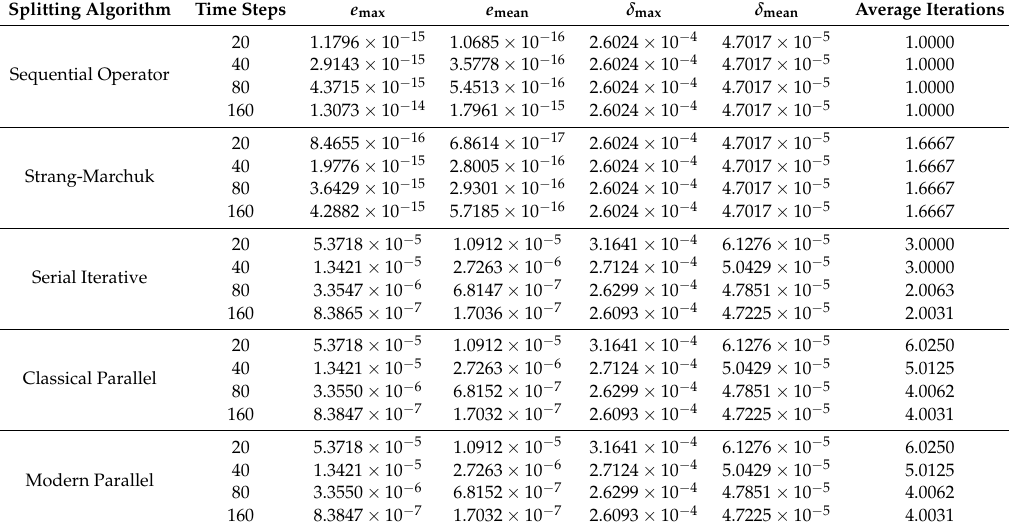
Table 8. Diffusion problem. Results of the balanced decomposition using the fourth order scheme for the spatial discretization, with 10 spatial subintervals and different number of temporal